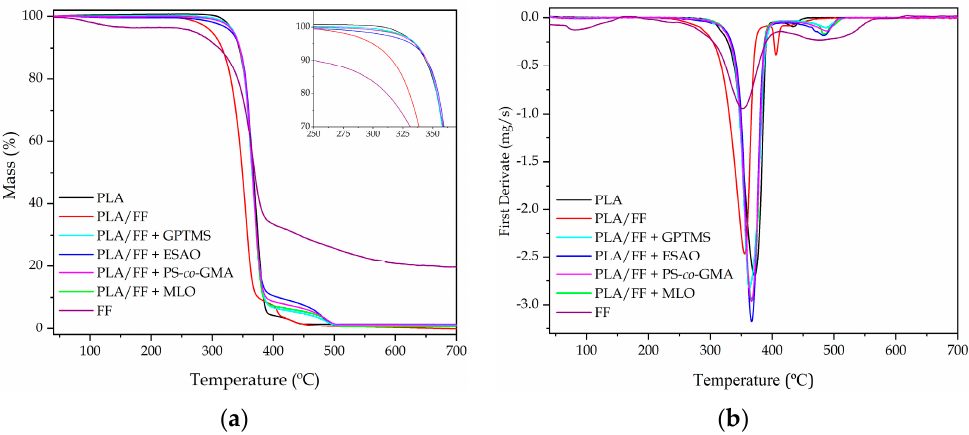
Figure 6. ( a ) Thermogravimetric analysis (TGA) curves with inset zooming the onset of degradation; and ( b ) first derivate thermogravimetric (DTG) curves corresponding to the polylactide (PLA) / flaxseed fiber (FF) pieces compatibilized with (3-glycidyloxypropyl) trimethoxysilane (GPTMS), epoxy-based styrene-acrylic oligomer (ESAO), poly(styrene- co -glycidyl methacrylate) (PS- co -GMA), and maleinized linseed oil (MLO).